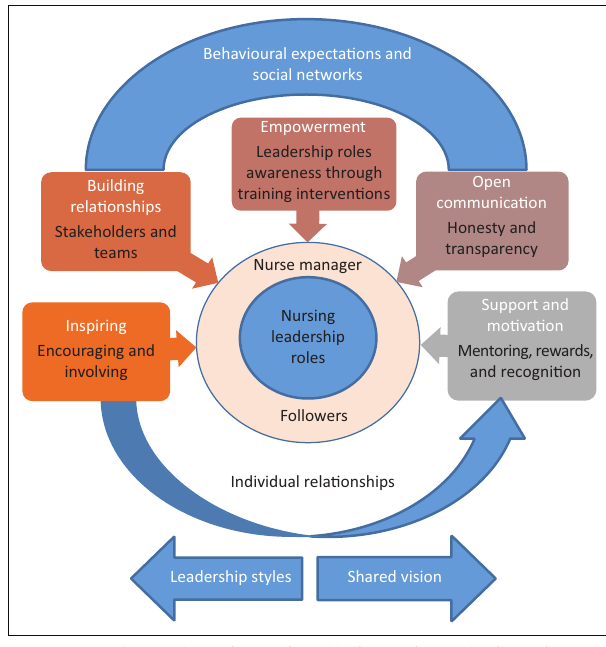
FIGURE 1: Conceptual framework of nurse managers’ leadership roles in a specific mining primary healthcare service.